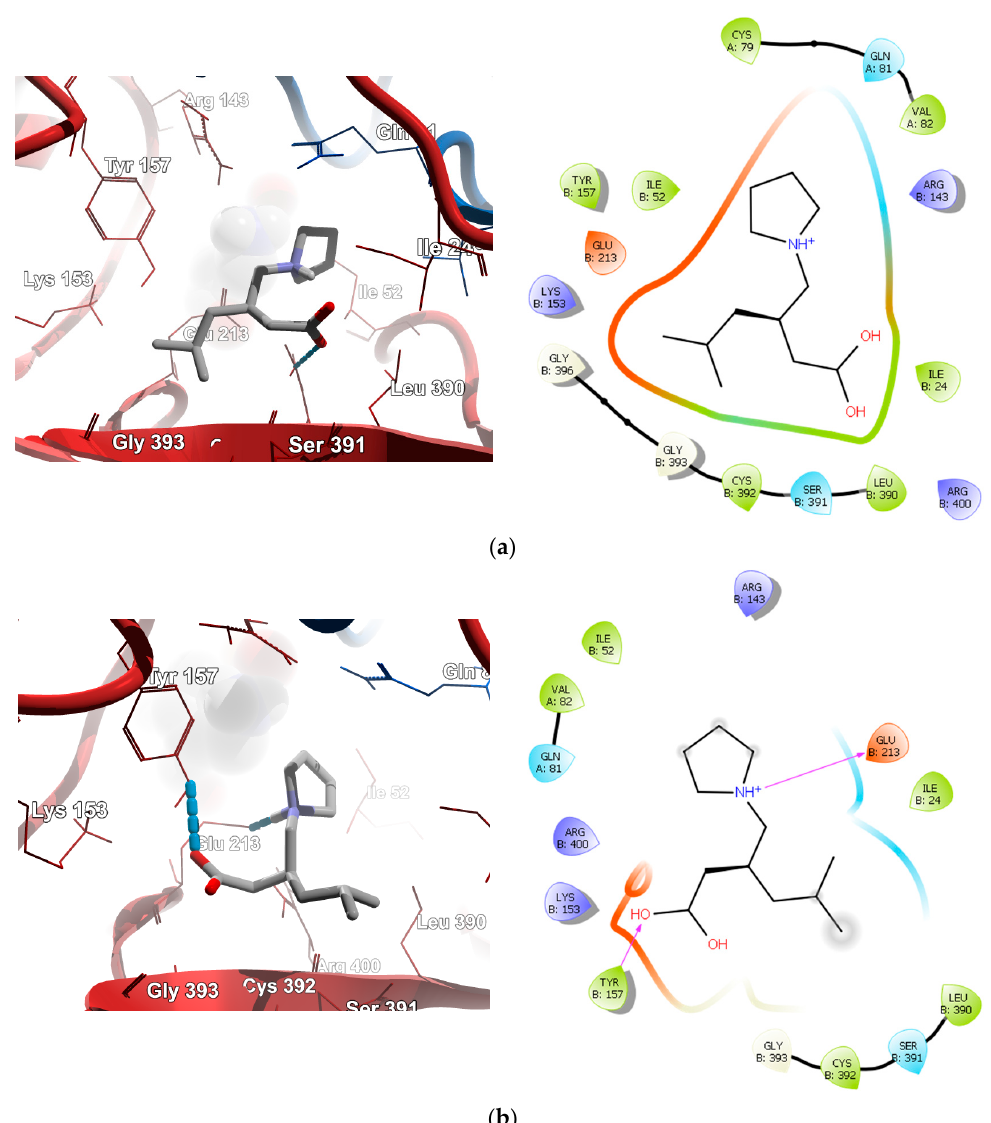
Figure 10. ( a ) ( R) - 18a hydrogen bond interactions (blue dashed lines) with Pseudomonas GABA-AT; ( b ) ( S) - 18a hydrogen bond interactions (blue dashed lines) with P seudomonas GABA-AT. The PLP prosthetic group is shown as spacefill model in the back of the image. The images were made with Molegro programs.